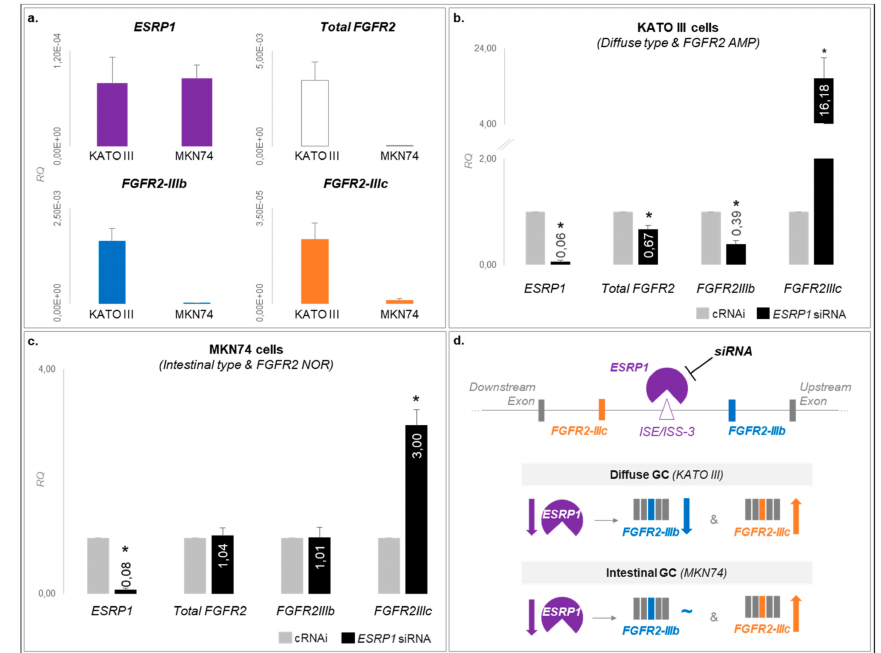
Figure 5. ESRP1 controls FGFR2 isoform expression in a distinct manner according to GC cell